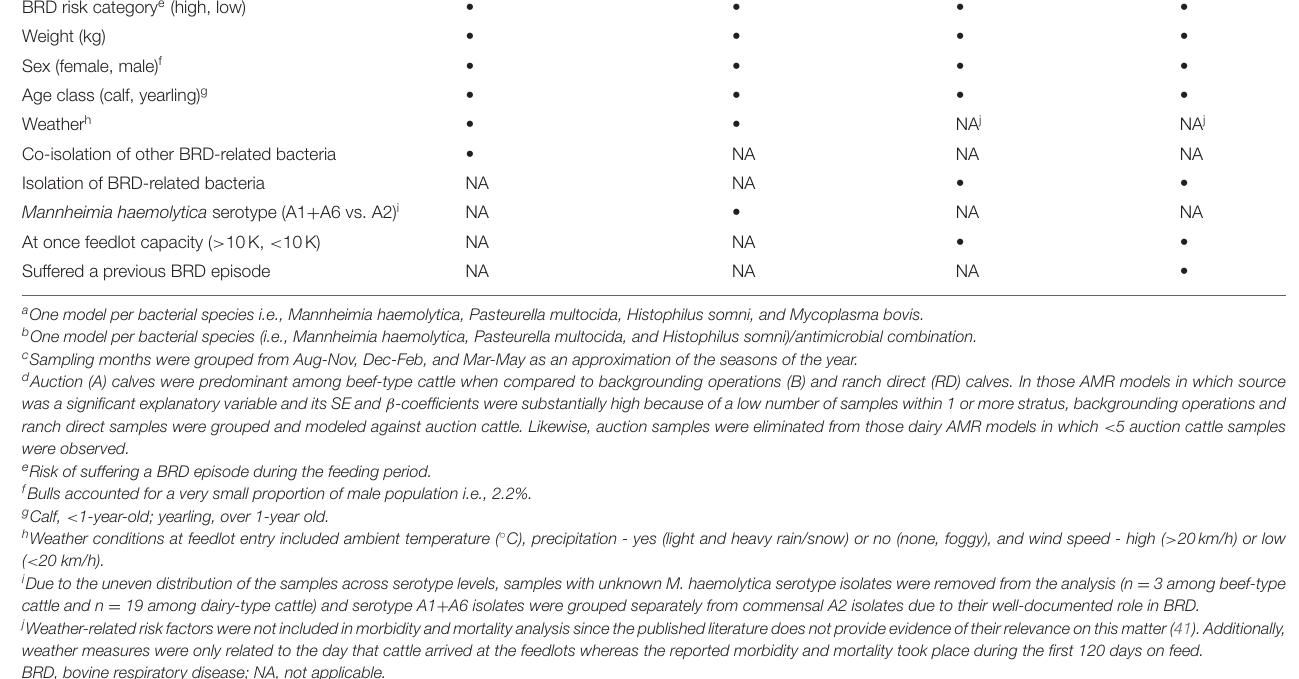
Outcome BRD-related Isolation of AMR BRD bacteria b bacteria a